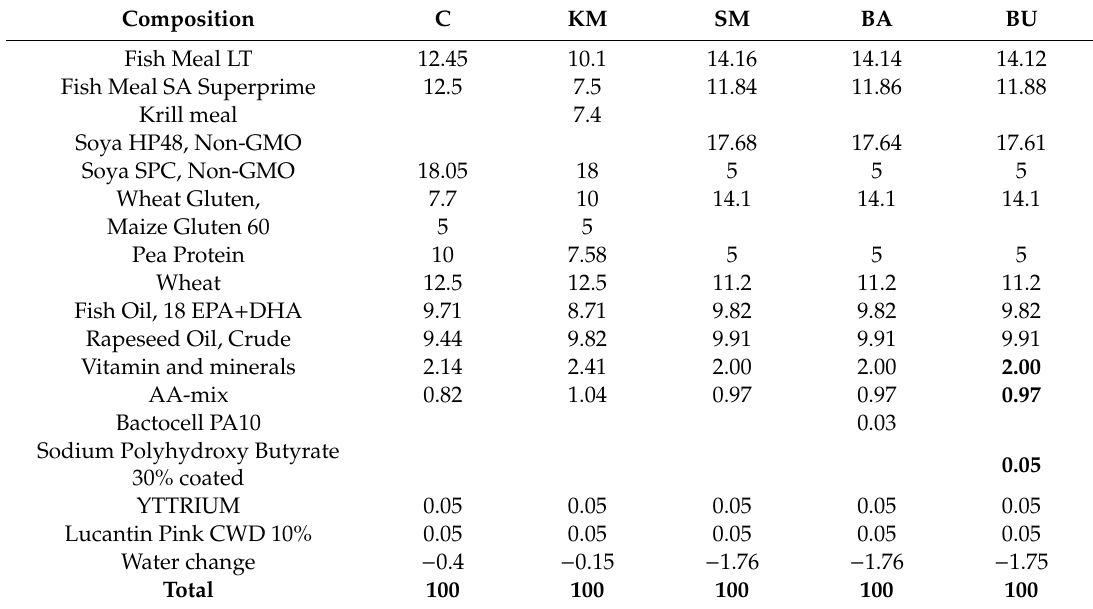
Table 2. Composition (%) of the five feeds used in the present study. Control diet © , krill meal (KM), soybean meal (SM), Bactocell ® (BA), and butyrate-rich (BU) diets.